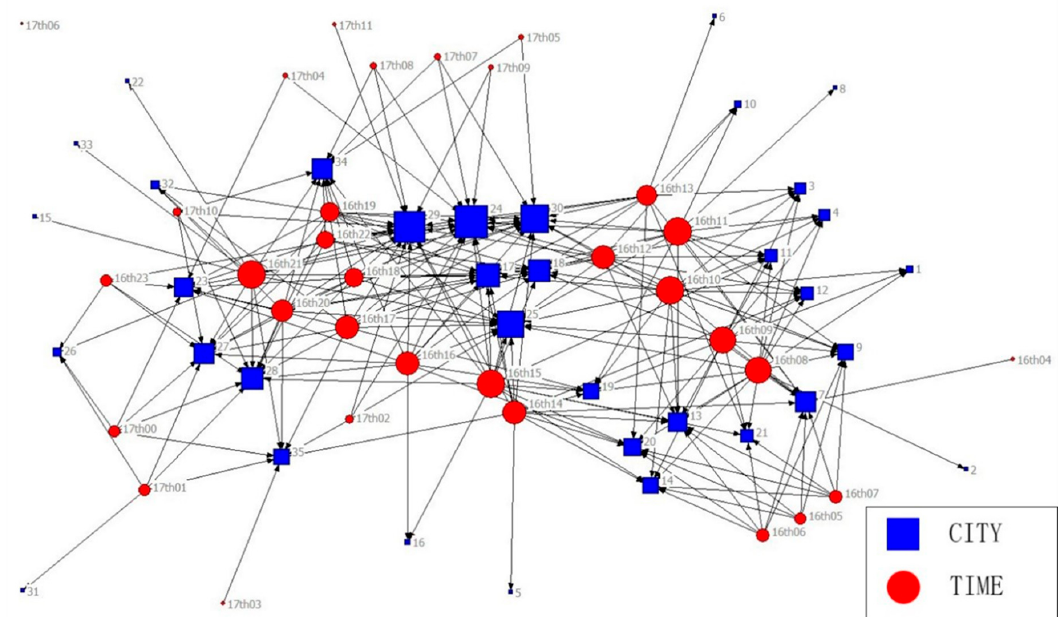
Figure 6. Visual disaster network of Typhoon Mangkhut in China. Notes: The label of a node in “Time” is created by “day+hour”. For example, “17th01” means 17th September, 01:00:00. There was no city impacted by multi-hazards at 6 o’clock, 17th September.